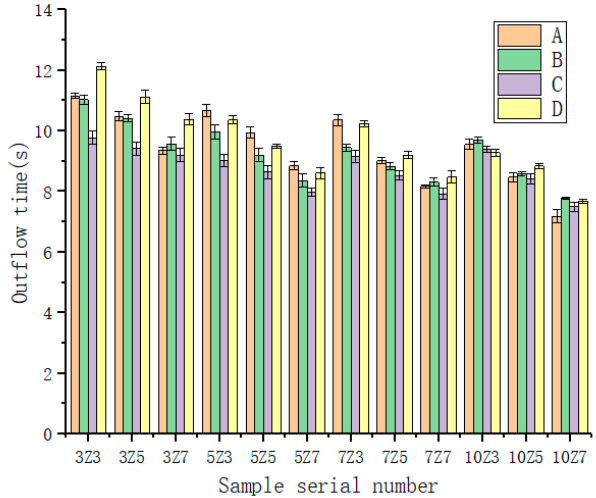
Figure 5. Liquidity of water-retentive mortar in different SAP types.